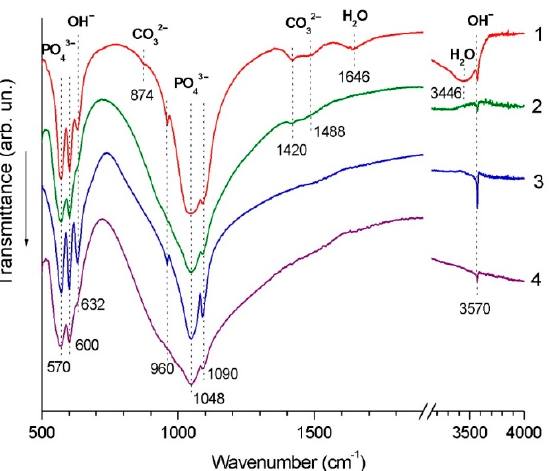
Figure 7. FTIR spectra of nano-HA powder (1), detonation coating obtained from nano-HA powder (2), calc-HA powder (3), detonation coating obtained from calc-HA powder (4). XRD phase analysis of the coating shows that, in both cases, the coating is single-phase. The XRD patterns of the coated samples (Figure 8) demonstrate only reflections of HA and metallic substrate (titanium).